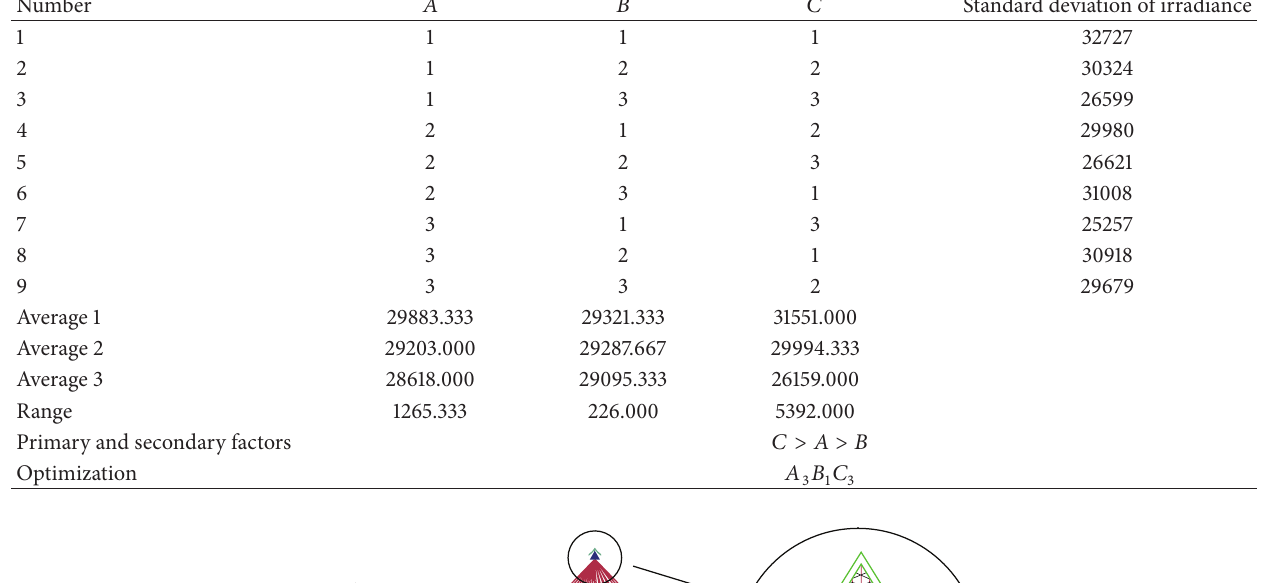
Table 4: The orthogonal experimental results of standard deviation of irradiance on cavity absorber.